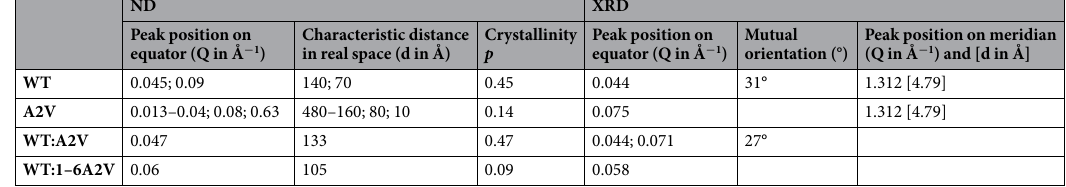
Table 1. Parameters deduced from Neutron and x-ray Diffraction